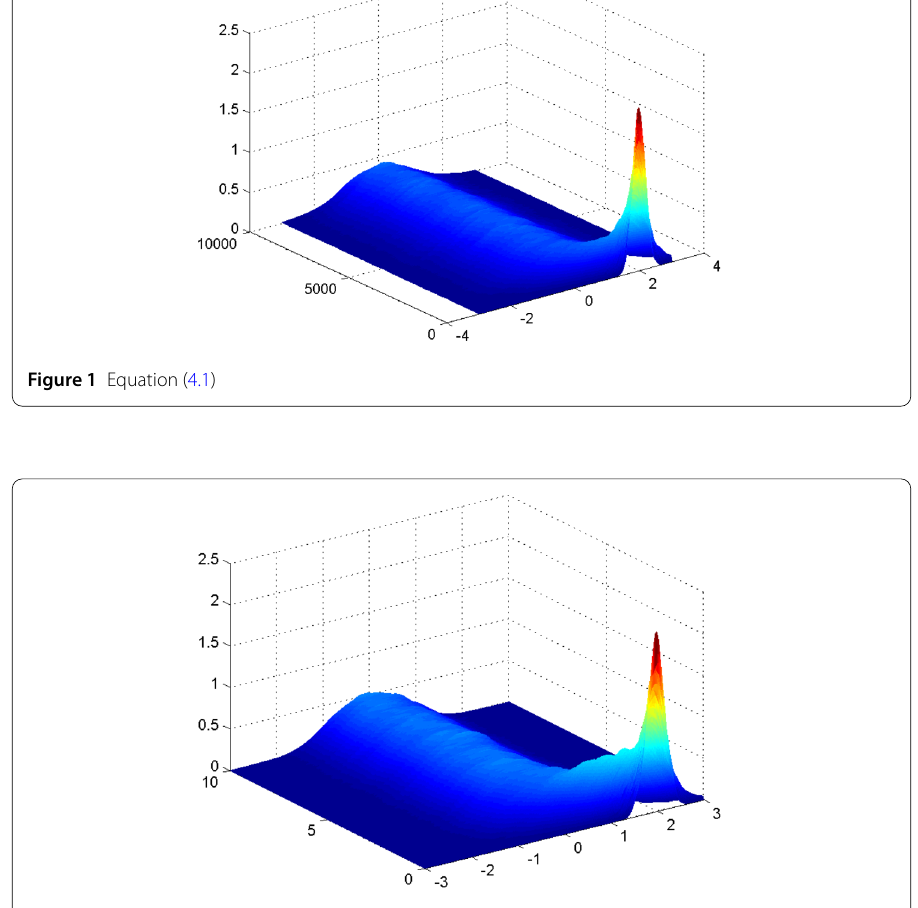
Figure 2 Equation